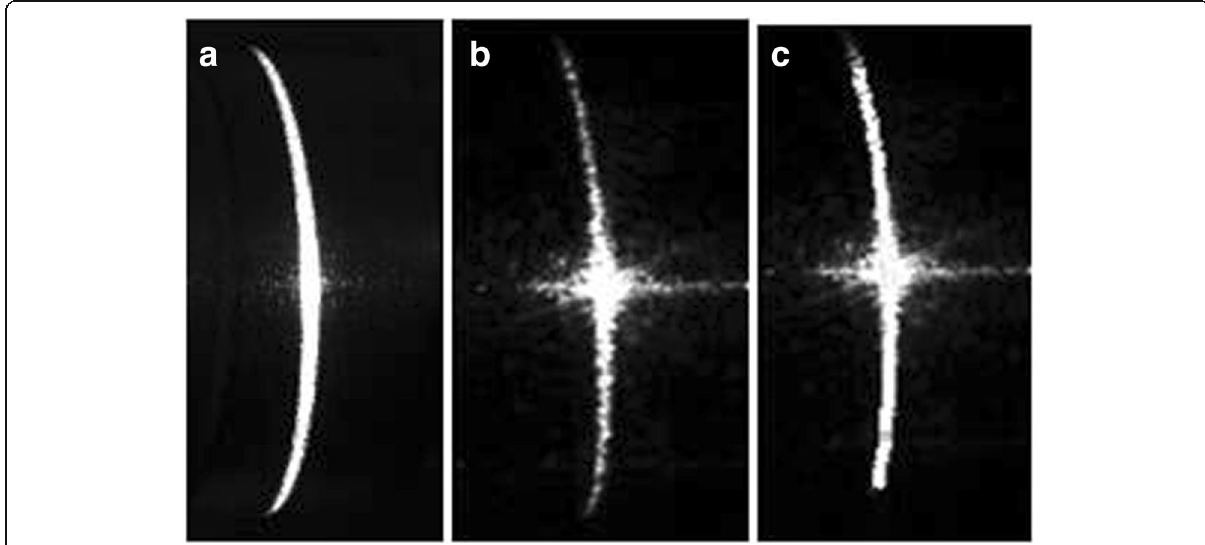
Fig. 15 The light stripe images before and after enhancement on the shafts. a The template image b The image before enhancement c The image after